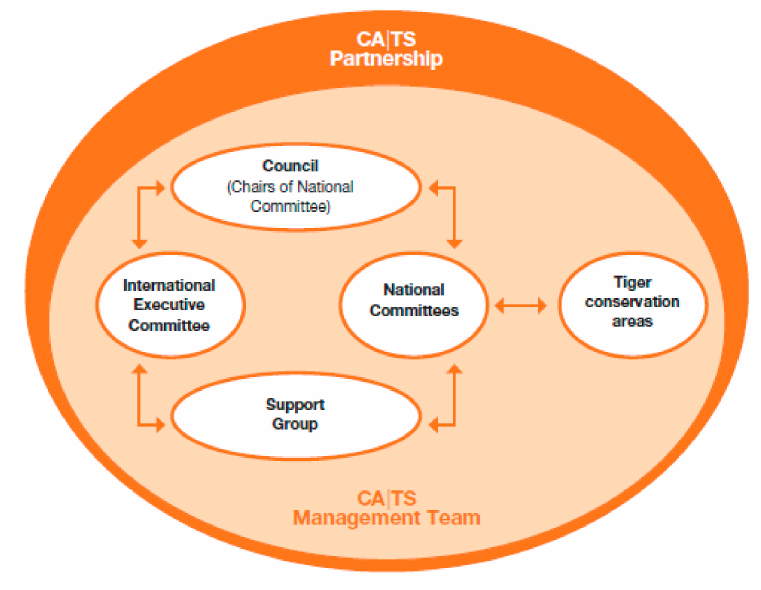
Figure 2. Conservation Assured|Tiger Standards (CA|TS) management